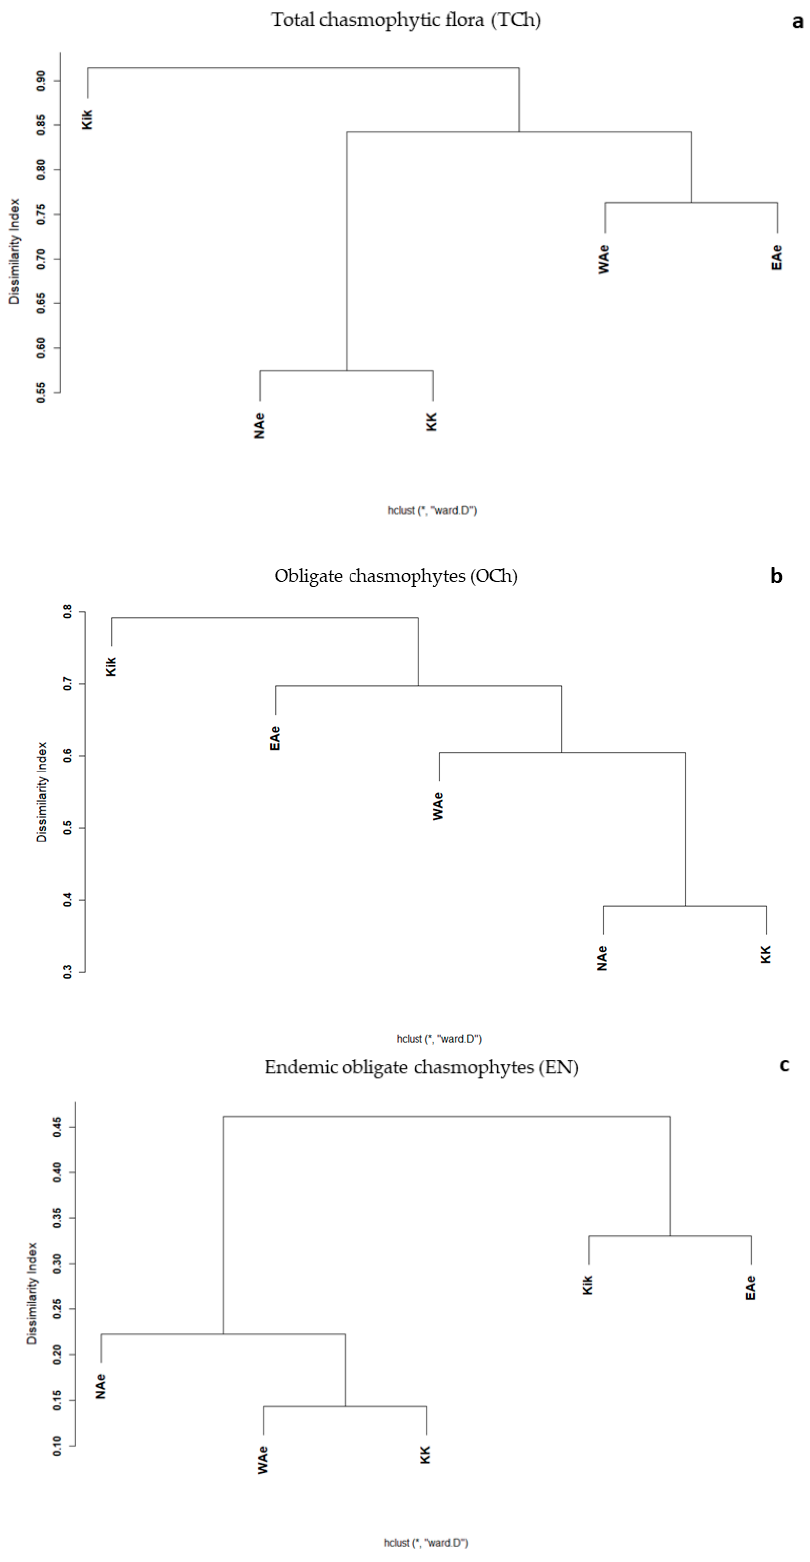
Figure 7. Hierarchical cluster analysis showing floristic similarity of the chasmophytic flora among the 5 island phytogeographical regions of the Aegean for ( a ) total (TCh), ( b ) obligate (OCh), and ( c ) endemic obligate (EN) chasmophytes. Abbreviations: NAe = North Aegean, WAe = West Aegean, EAe = East Aegean, Kik: Cyclades islands, KK = Crete-Karpathos phytogeographical region.